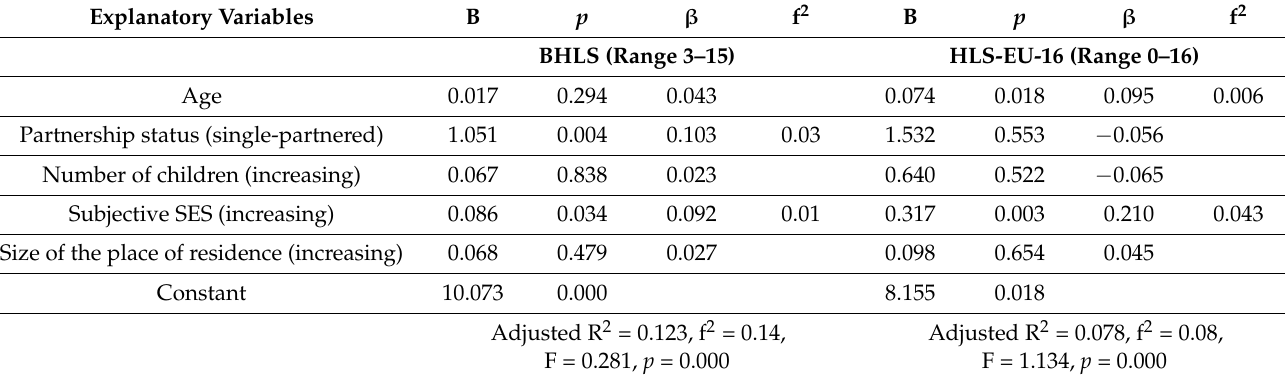
Table 4. The determinants of mothers’ health literacy according to the two